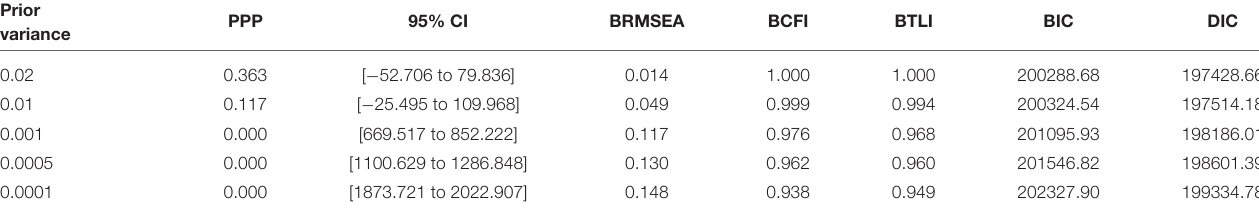
TABLE 6 | Fit statistics of the BAMI models.